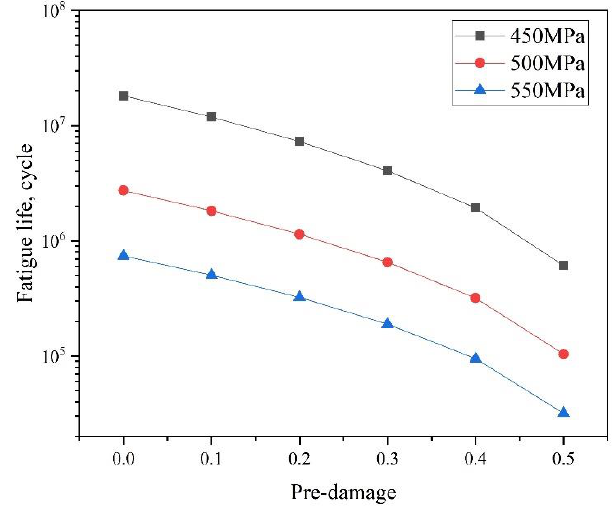
Figure 10. Effect of predamage on fatigue life at different stress amplitude.